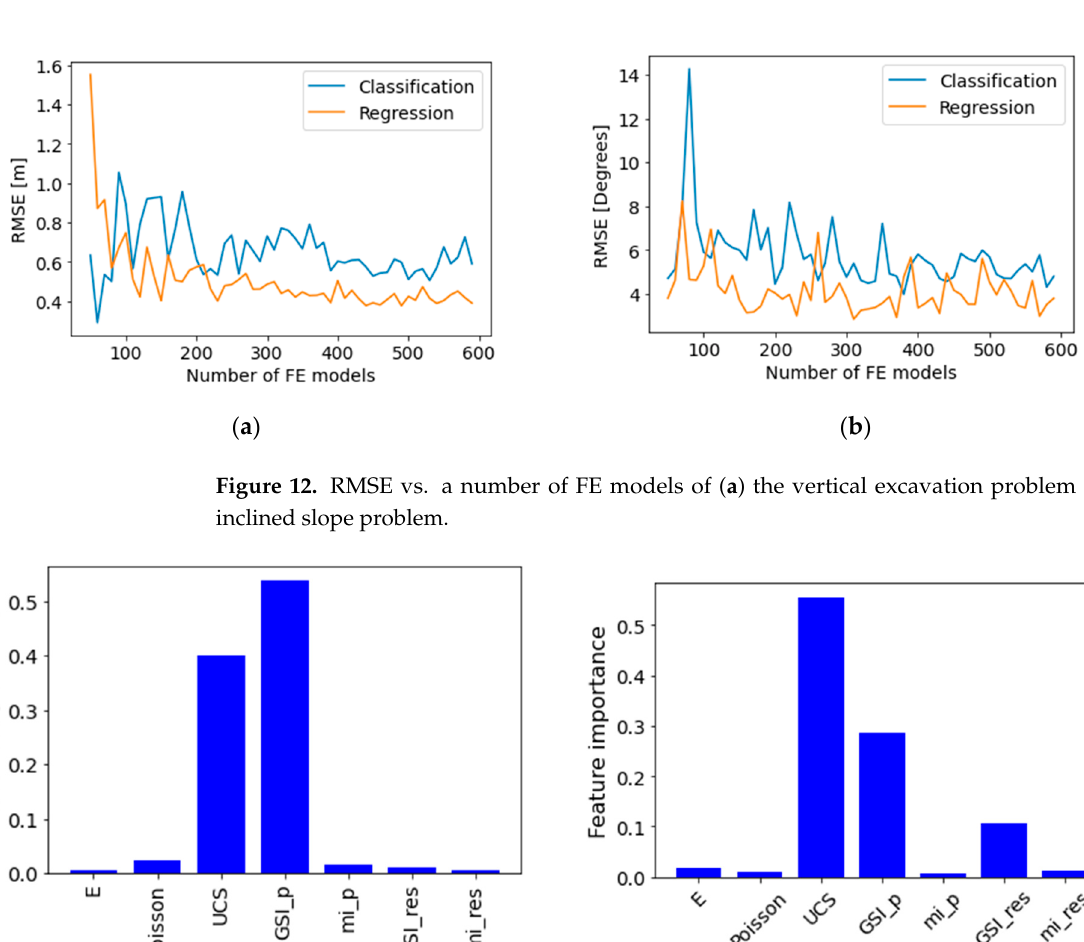
Figure 11. Confusion matrix of the RFC model for the ( a ) the vertical excavation problem and ( b ) the slope problem.